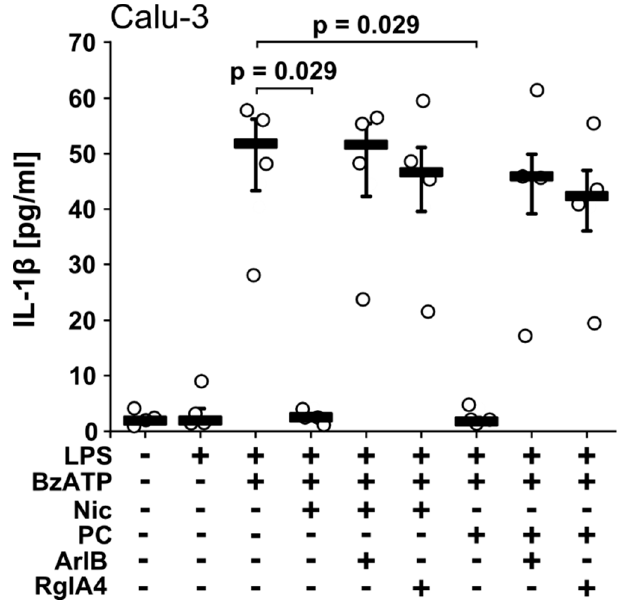
Figure 2. Nicotine (Nic) and phosphocholine (PC) inhibit the release of IL-1 β by Calu-3 cells. Human LPS-primed Calu-3 cells were stimulated with BzATP (100 µM) in the presence or absence of Nic (100 µM) or PC (100 µM). [V11L, V16D]ArIB (500 nM) or RgIA4 (200 nM) was added together with BzATP and IL-1 β released to the supernatant was measured after 30 min. In one of the experiments, IL-1 β levels released in response to BzATP was low throughout. Data are presented as individual data points, bars represent median, whiskers encompass the 25th to 75th percentile, n = 4 per experiment. Experimental groups were compared by Kruskal Wallis test followed by Mann Whitney rank sum test.